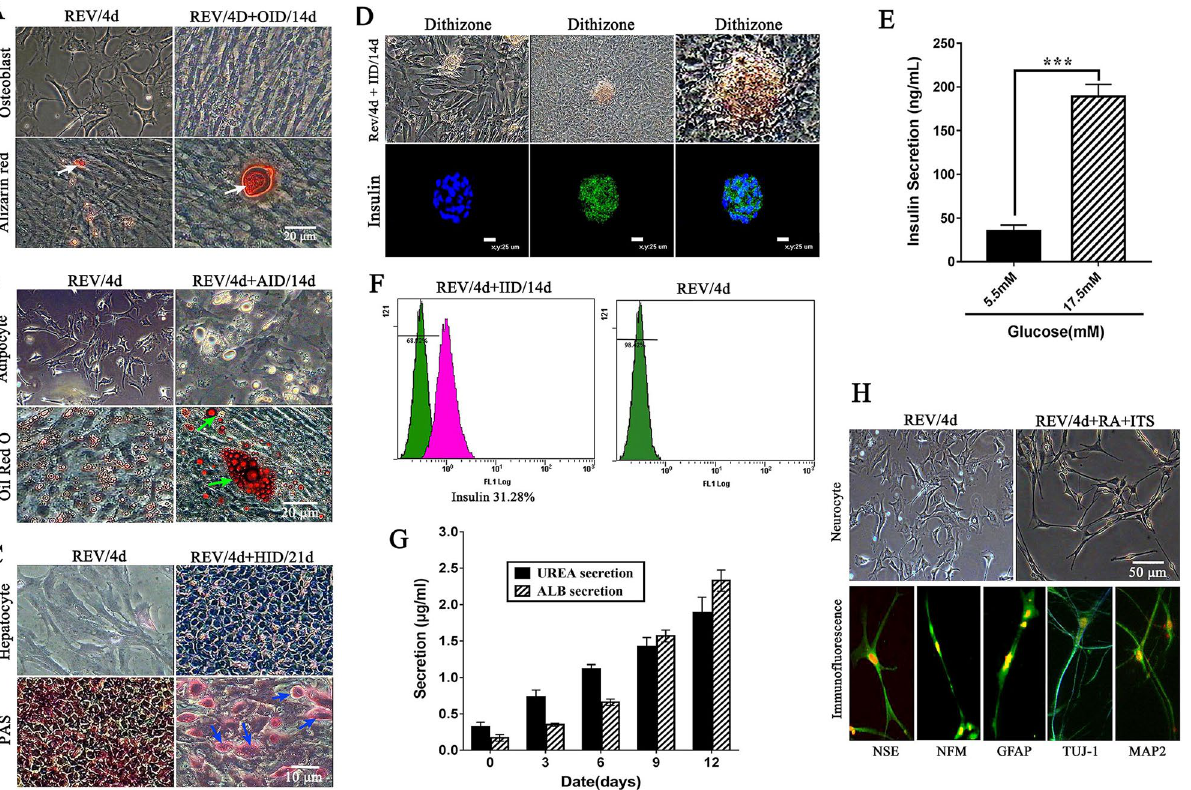
Figure 6. Reversine treatment promoted the differentiation potential of sheep fibroblasts. ( A ) Calcium deposits within induced osteoblasts were positive for Alizarin red staining. ( B ) Intracellular lipid droplets of adipocytes accumulated in cytoplasm and were positive for Oil Red-O staining. ( C ) The hepatogenic differentiated cells were positive by PAS staining assay cultured in HID for 21 days. ( D ) The islet-like clusters were stained scarlet with DTZ fluid and immunofluorescence staining for insulin. ( E ) Glucose induced insulin secretion (Mean ± SEM) in vitro at 5.5 mM and 17.5 mM by ELISA test, ***p < 0.001; ( F ) Only 31.28 ± 2.32% reversine treated fibroblasts were differentiated into insulin-secreting cells. ( G ) Expression of hepatogenic cells marker genes ALB and AFB were analyzed ELISA test. ( H ) Expression of neural specific markers (MAP2, NFM, NSE, GFAP and TUJ-1) were all positive by immunofluorescence